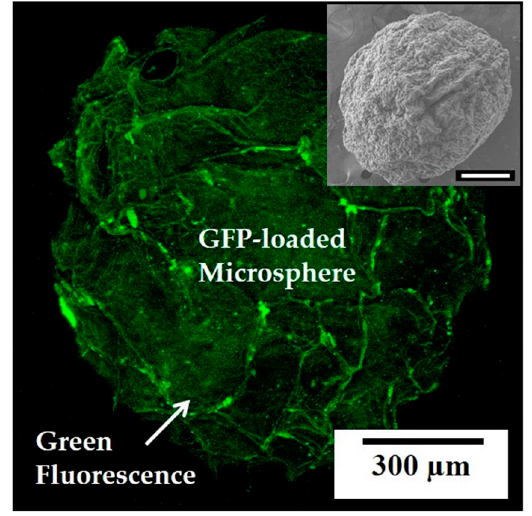
Figure 10. Representative CLSM image of the green fluorescent protein (GFP) oaded collagen microsphere. The inset shows the SEM image of the GFP-loaded collagen microsphere (scale = 300 µm).